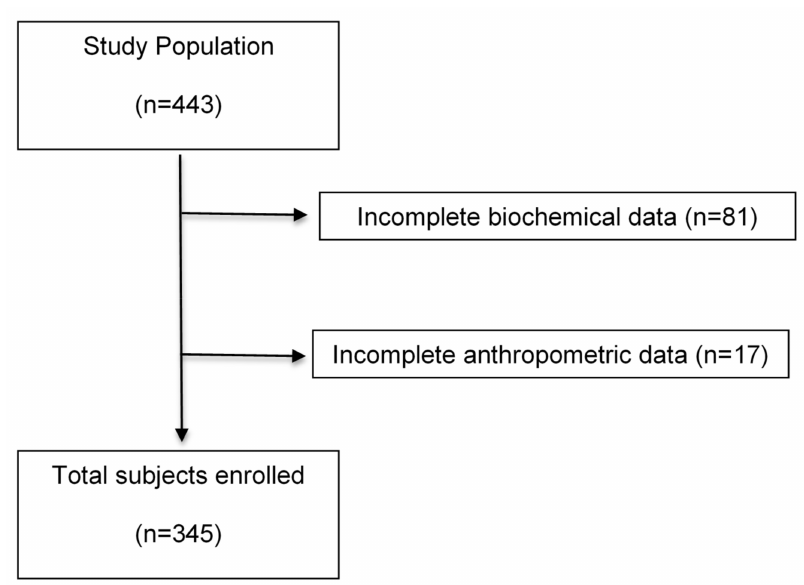
Figure 1. Flow diagram of subjects included in this